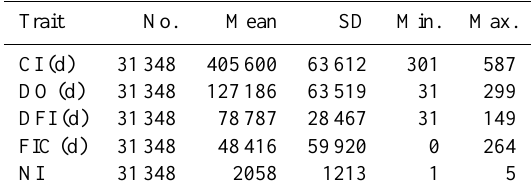
Table 1. Number of records, mean, standard deviation (SD), mini- mum, and maximum for CI, DO, DFI, FIC, and NI. Trait No. Mean SD Min.